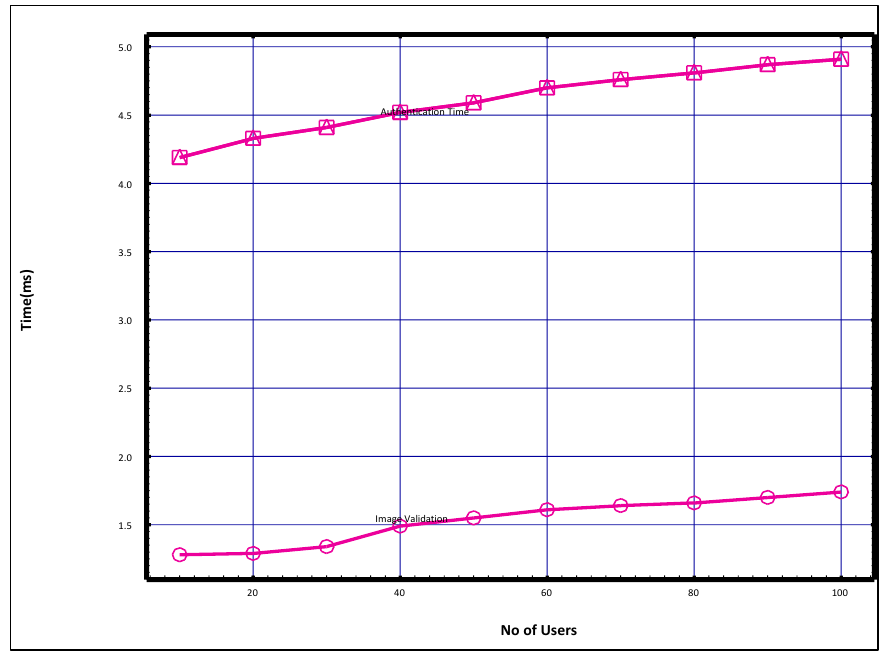
Figure 4: Image Validation and Authentication